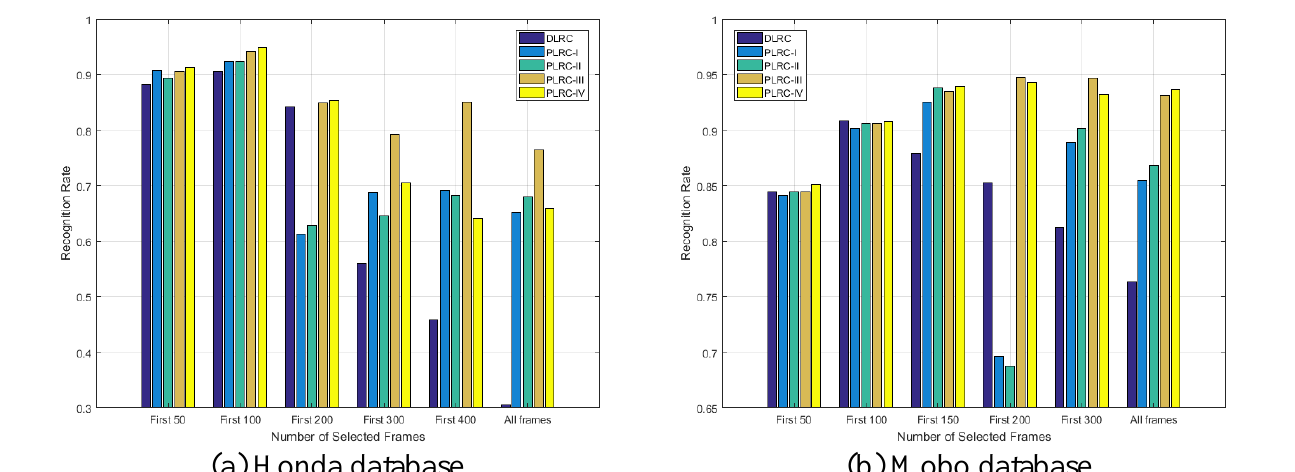
Figure 4. The experimental results of DLRC and PLRC methods from two popular databases, with varying numbers of